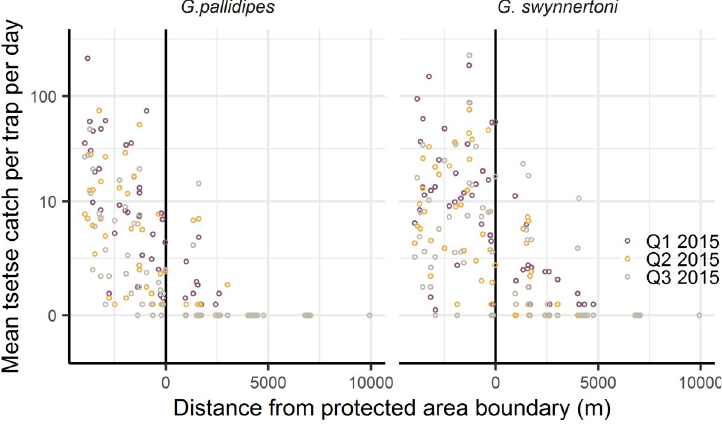
Fig 1. Mean numbers of tsetse caught across the wildlife-livestock interface by season and species during 2015.